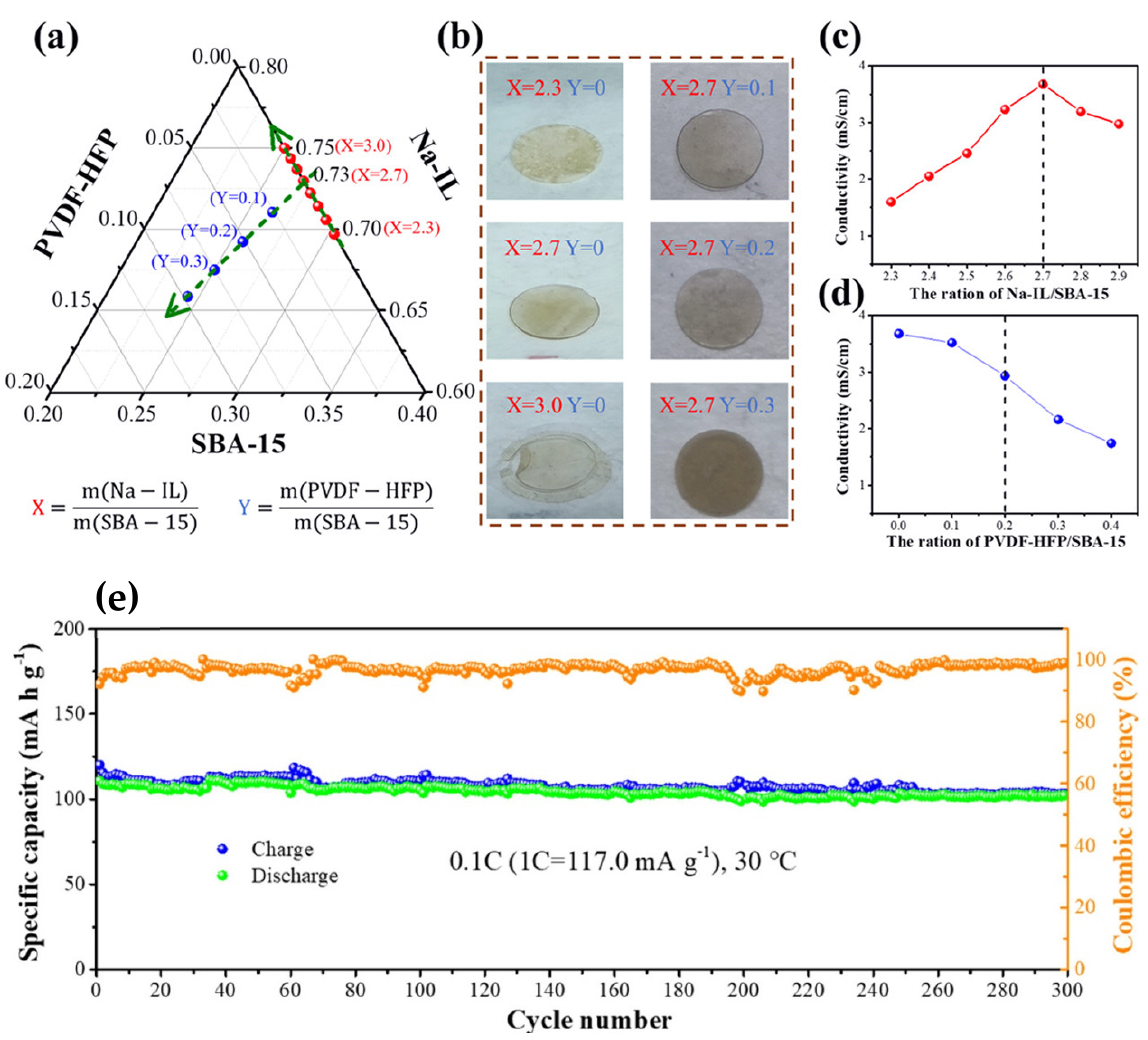
Figure 5. Proportion regulation and optimization of components in Na-IL/P(VDF–HFP)@SBA-15: ( a ) ternary phase diagram of Na-IL/PVDF–HFP@SBA-15 with different X and Y values; X, mass ra-